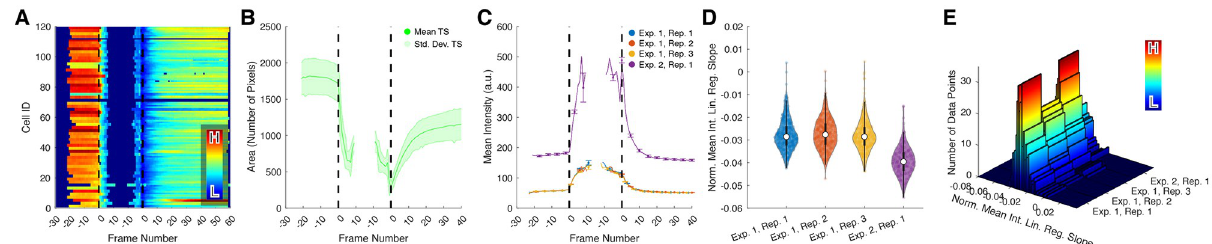
Fig 2. Visualization options of LiveCellMiner. The LiveCellMiner extension provides multiple ways of data visualization. (A) Temporally aligned heatmaps of feature time series (color encodes the feature value, e.g. , the area in numbers of pixels as in this example), (B) mean ± std. dev. curves summarizing all trajectories of a particular position or experiment in a separate subplot, (C) mean curves of multiple experiments with error bars plotted in a single axis for better comparability, (D) violin or box plots of single feature values and (E) histograms of individual data points grouped according to the current selection. See S12 Fig for more information about the time axis used for plotting temporal features.